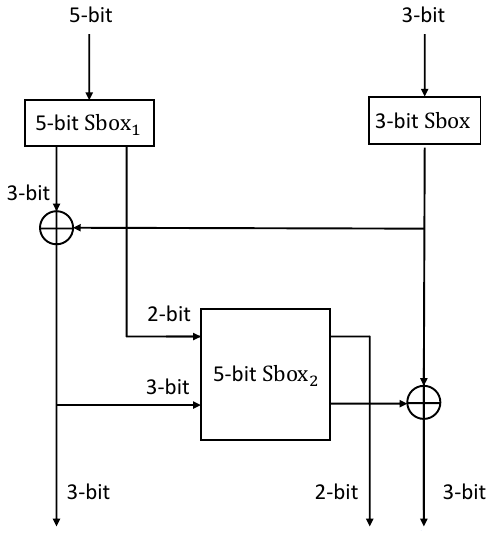
Figure 3. Unbalanced-bridge structure of PIPO